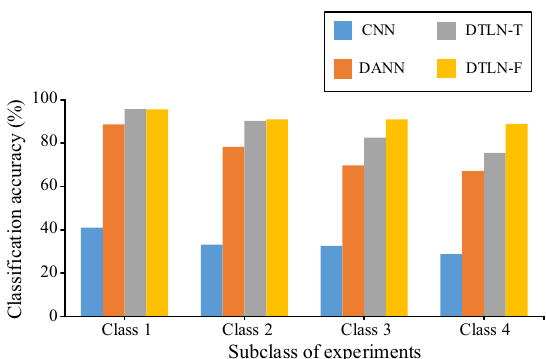
Fig. 8 Classification accuracy of average tenfold cross validation on the subclass of experiments